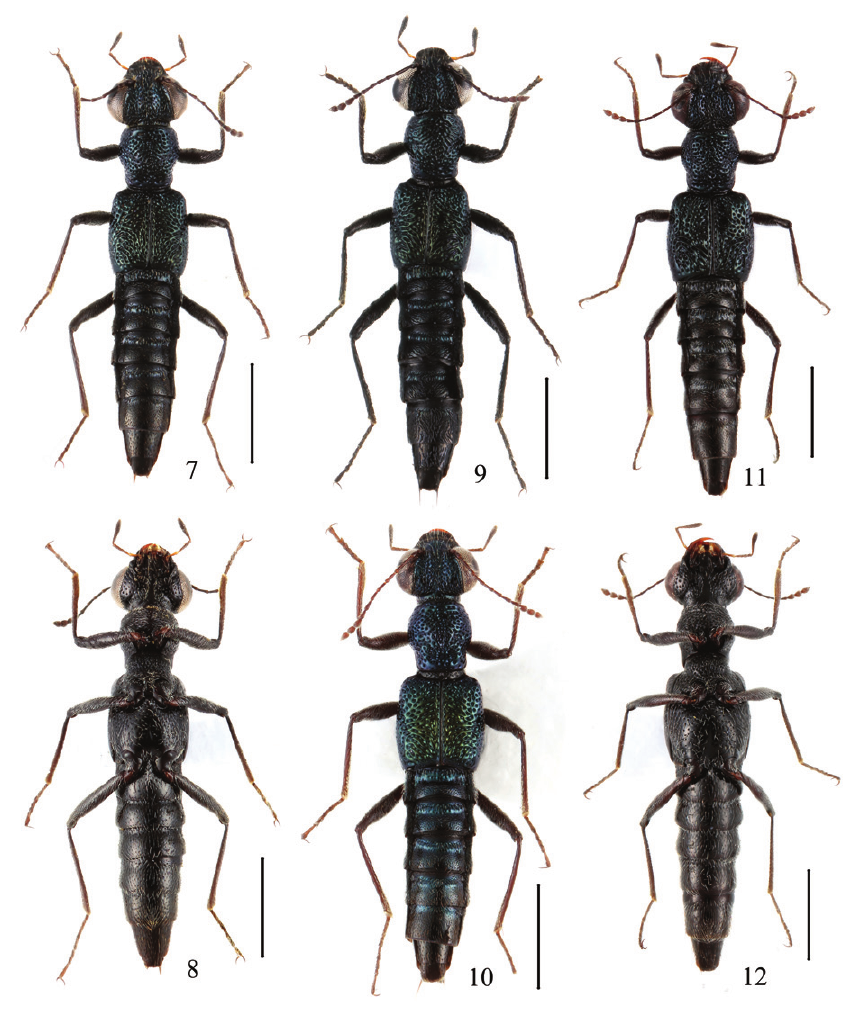
Female. Eighth sternite (Fig. 51) pointed posteromedially; valvifer (Fig. 52) with poste- rior margin finely serrate; 10th tergite (Fig. 53) with the posterior margin broadly pointed. Distribution. China (Jiangxi,